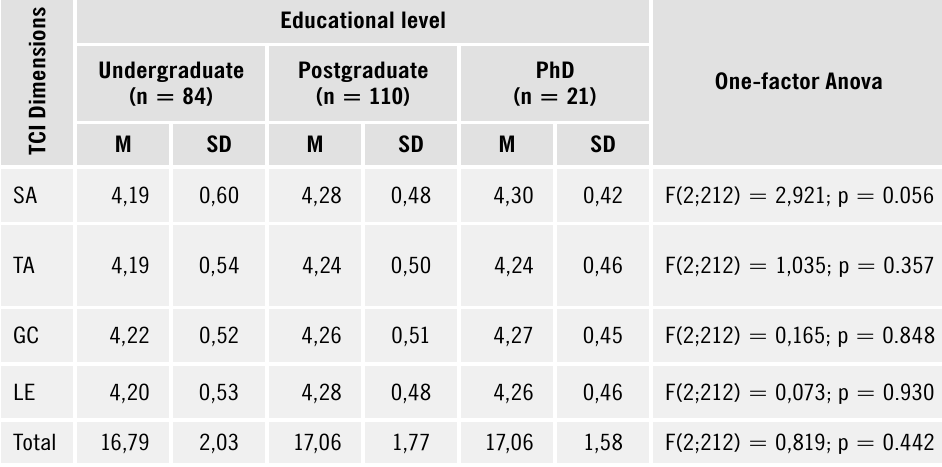
Table 8. Descriptive statistics with the one-factor Anova difference test between respondents of different Educational level for the group from